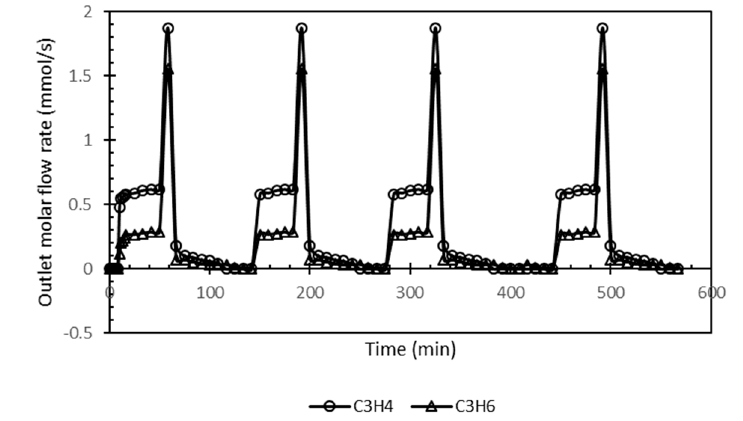
Figure 9. Whole VSA cycle outlet molar flow rate vs. time.